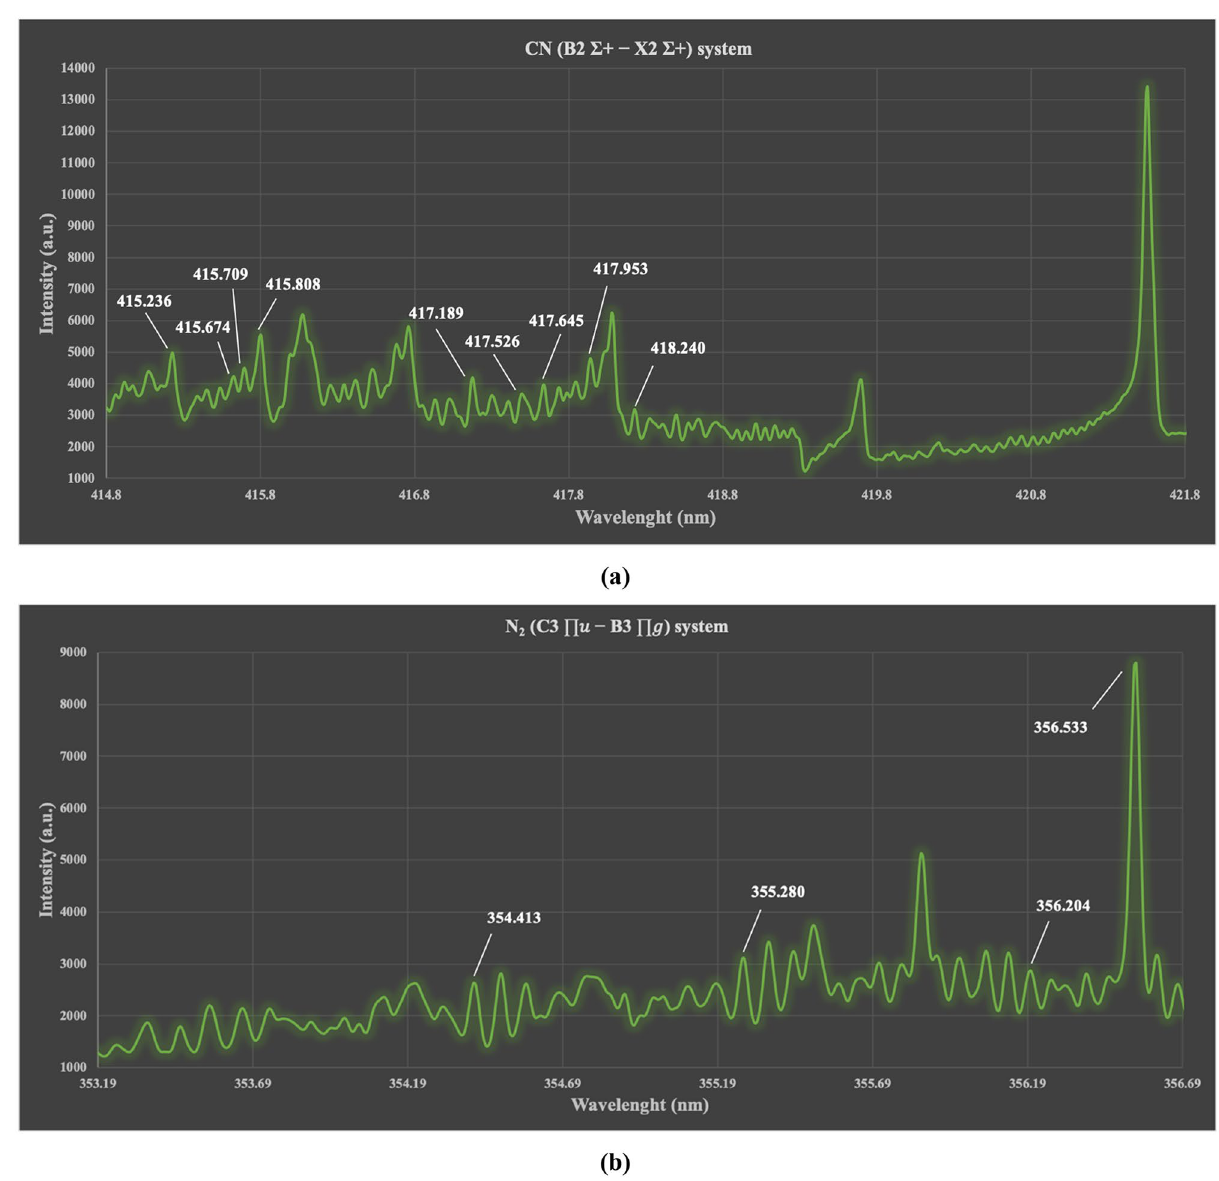
2 (cid:31) + − X 2 (cid:31) + 3 − B 3 ) and the N 2 ( C u g ) molecular systems detected into fs-Solstice (cid:31) (cid:31)